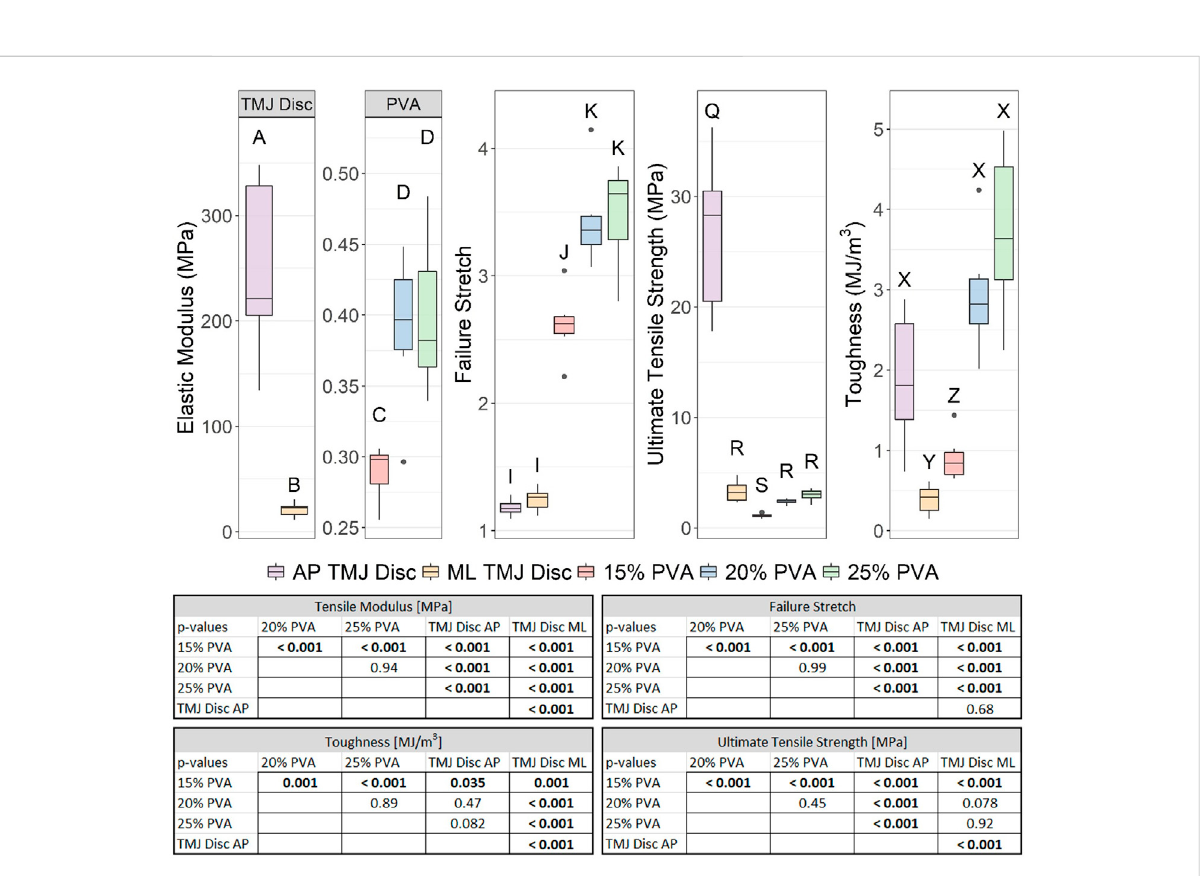
Box-and-whiskerplotsoftheelasticmodulus,failurestretch,ultimatetensilestrength,andfailurestretchfromthetensileevaluationofthePVA hydrogels and ovine TMJ discs [29]. Groups that do not share a letter were signi fi cantly different. All p – values for post hoc Tukey ’ s HSD tests are provided in the associated table